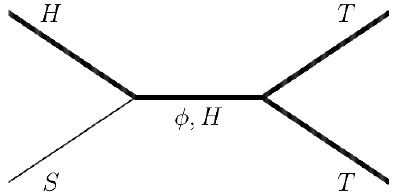
Figure 4 . Possible sources of correction to the sub-subleading soft graviton theorem for two graviton, two tachyon scattering in string theory. S denotes the soft graviton, T denotes external tachyon, H denotes (cid:12)nite energy external or internal graviton and (cid:30) denotes a (cid:12)nite energy internal dilaton. These represent additional contribution to (cid:12)gure 1 besides the one arising from the three point vertex (2.38) representing minimal